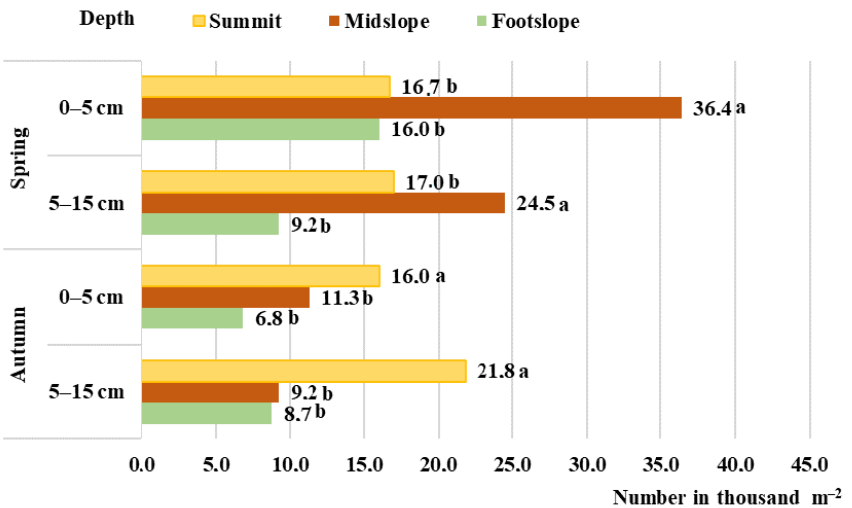
Figure 2. The number of seeds in a pre-erosion cereal-grass crop rotation soil in 2021. Letters “a” and “b” indicate significant ( p < 0.05) differences between the means.